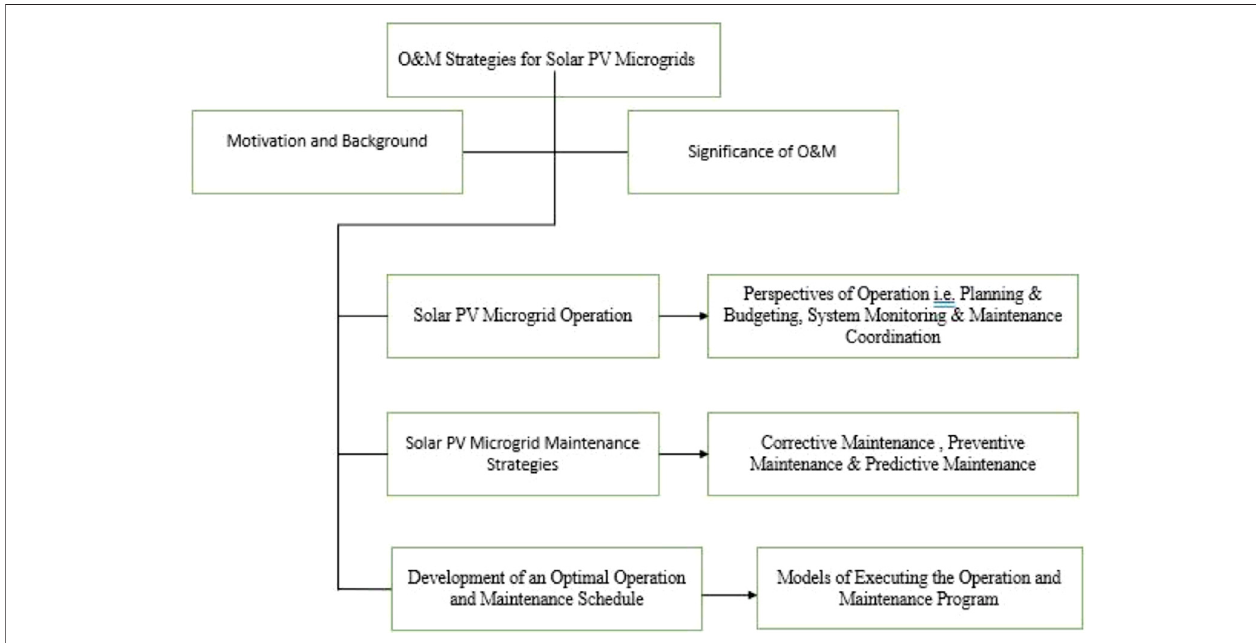
FIGURE 1 | Structure of the